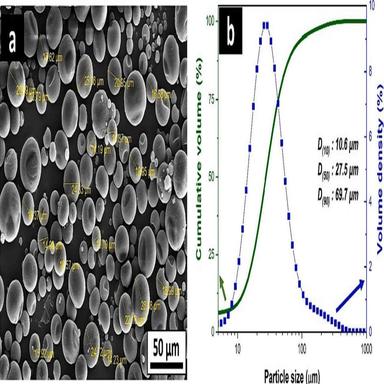
Particle morphology and size distribution of MEPCM used in the study.